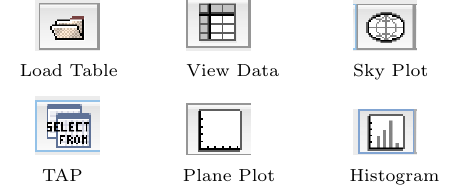
Fig. 51.— Some of the TOPCAT icons